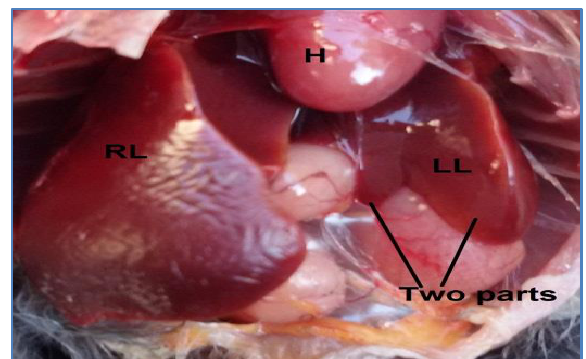
Figure, 1: Shows the location and shape of the liver in white-eared bulbul. The left lobe (LL), the right lobe (RL), the heart (H),